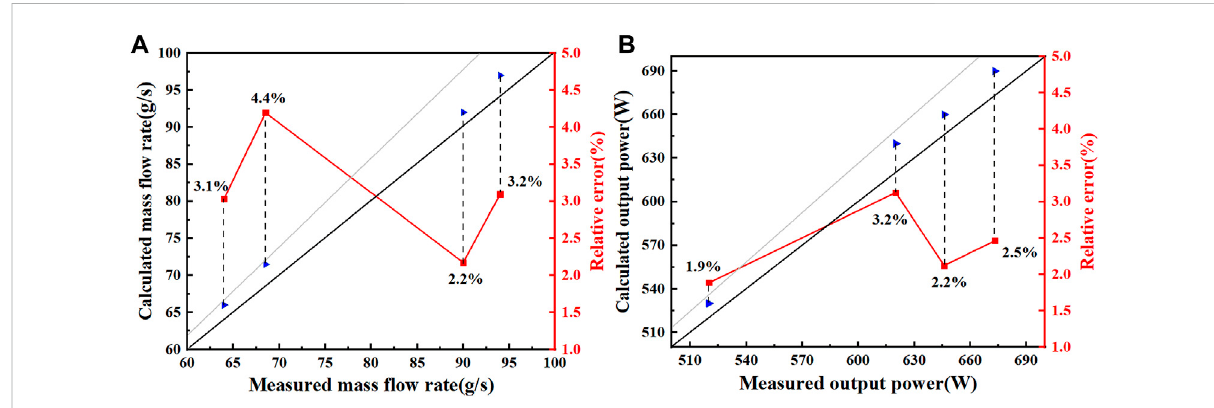
FIGURE 5 Comparisons between experimental and simulation results (A) mass fl ow rate and (B) output